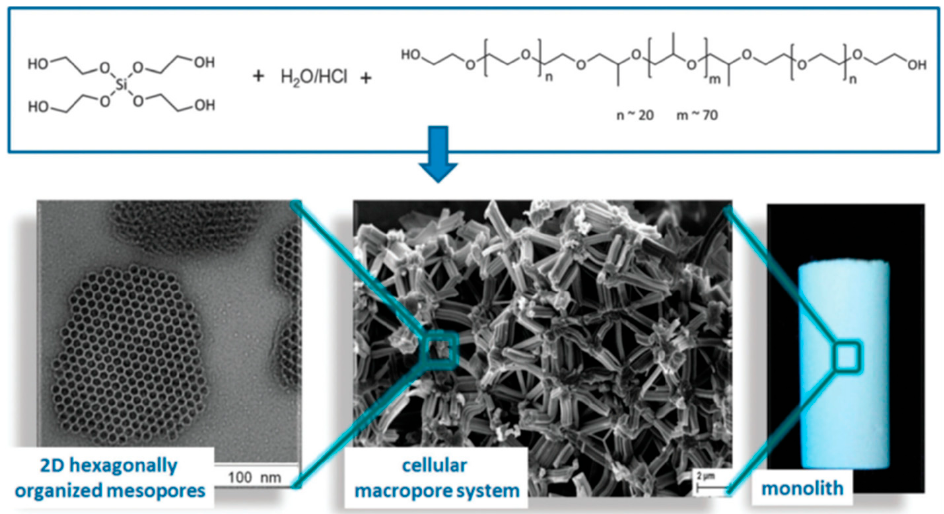
Figure 9. Increasing magnification, from right to left, of a silica monolith prepared from glycol- modified silane in the presence of P123 at pH = 1. Republished with permission of Royal Society of Chemistry (Great Britain), from Sol-gel synthesis of monolithic materials with hierarchical porosity, A. Feinle, MS. Elsaesser, N. Hüsing, 45, 12, 2015 [1]; permission conveyed through Copyright Clearance Center, Inc.